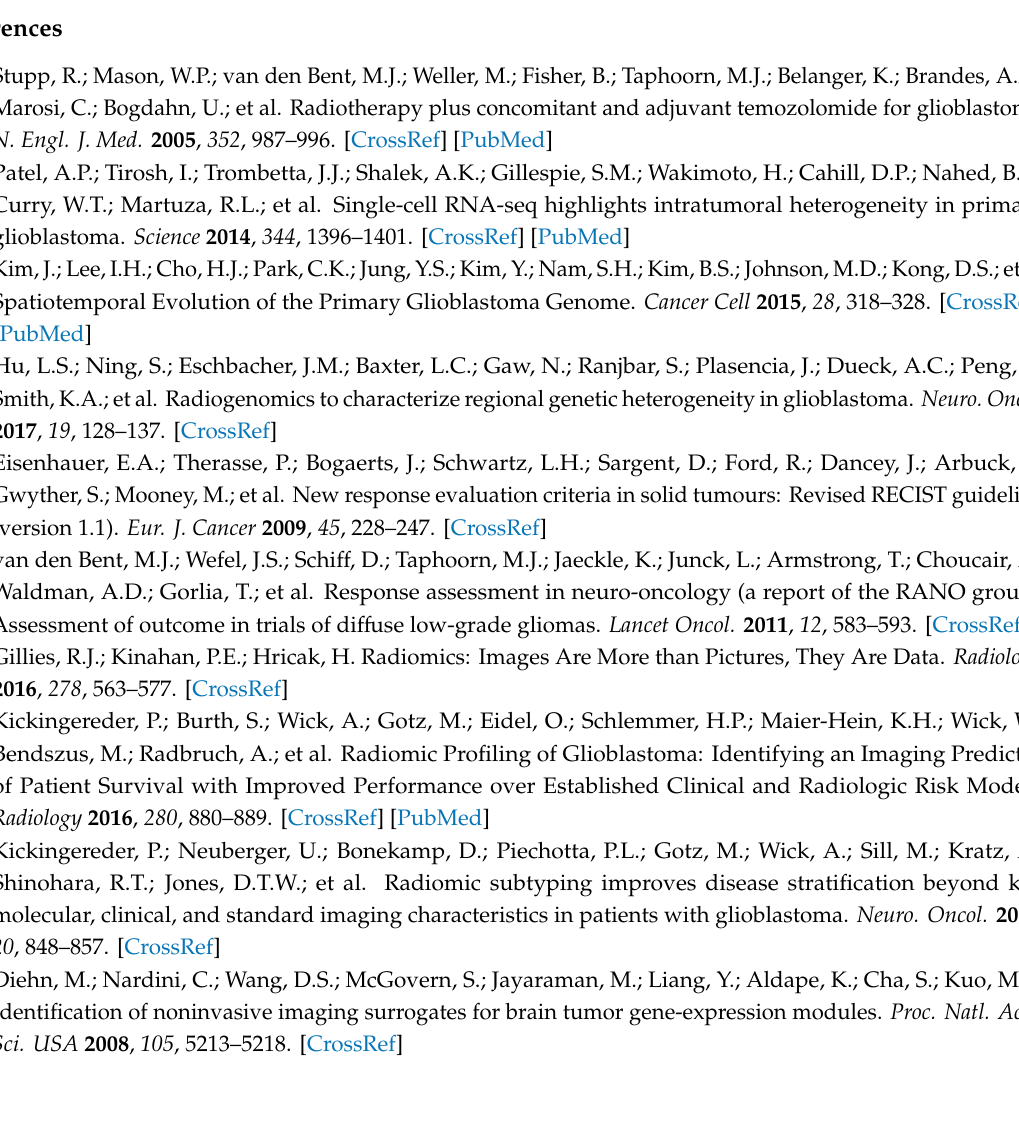
Figure S1: Decision of number of clusters (k) during consensus clustering, Figure S2: Principal component analysis of radiomics profiling of glioblastoma patients revealed the highlighted features per corresponding radiomics subtype, Figure S3: Comparison of radiomics feature values between radiomics subtypes, Figure S4: Hazard ratio plot derived from multi-variate cox regression analysis, Figure S5: Top 30 correlative gene sets to T2 autocorrelation (GLCM) feature, Figure S6: Characterized genomic signatures according to radiomics subtype, Table S1: Molecular and clinical characteristics of study cohorts. Table S2: Sensitivity analysis of the Cox regression